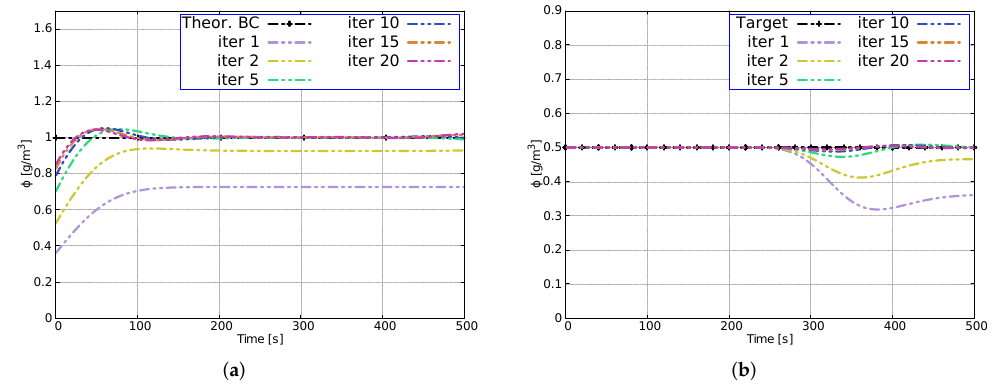
Figure 5. Case 1. Evolution of the reconstruction of the boundary condition ( a ) and evolution of the target ( b ) at some iterations.